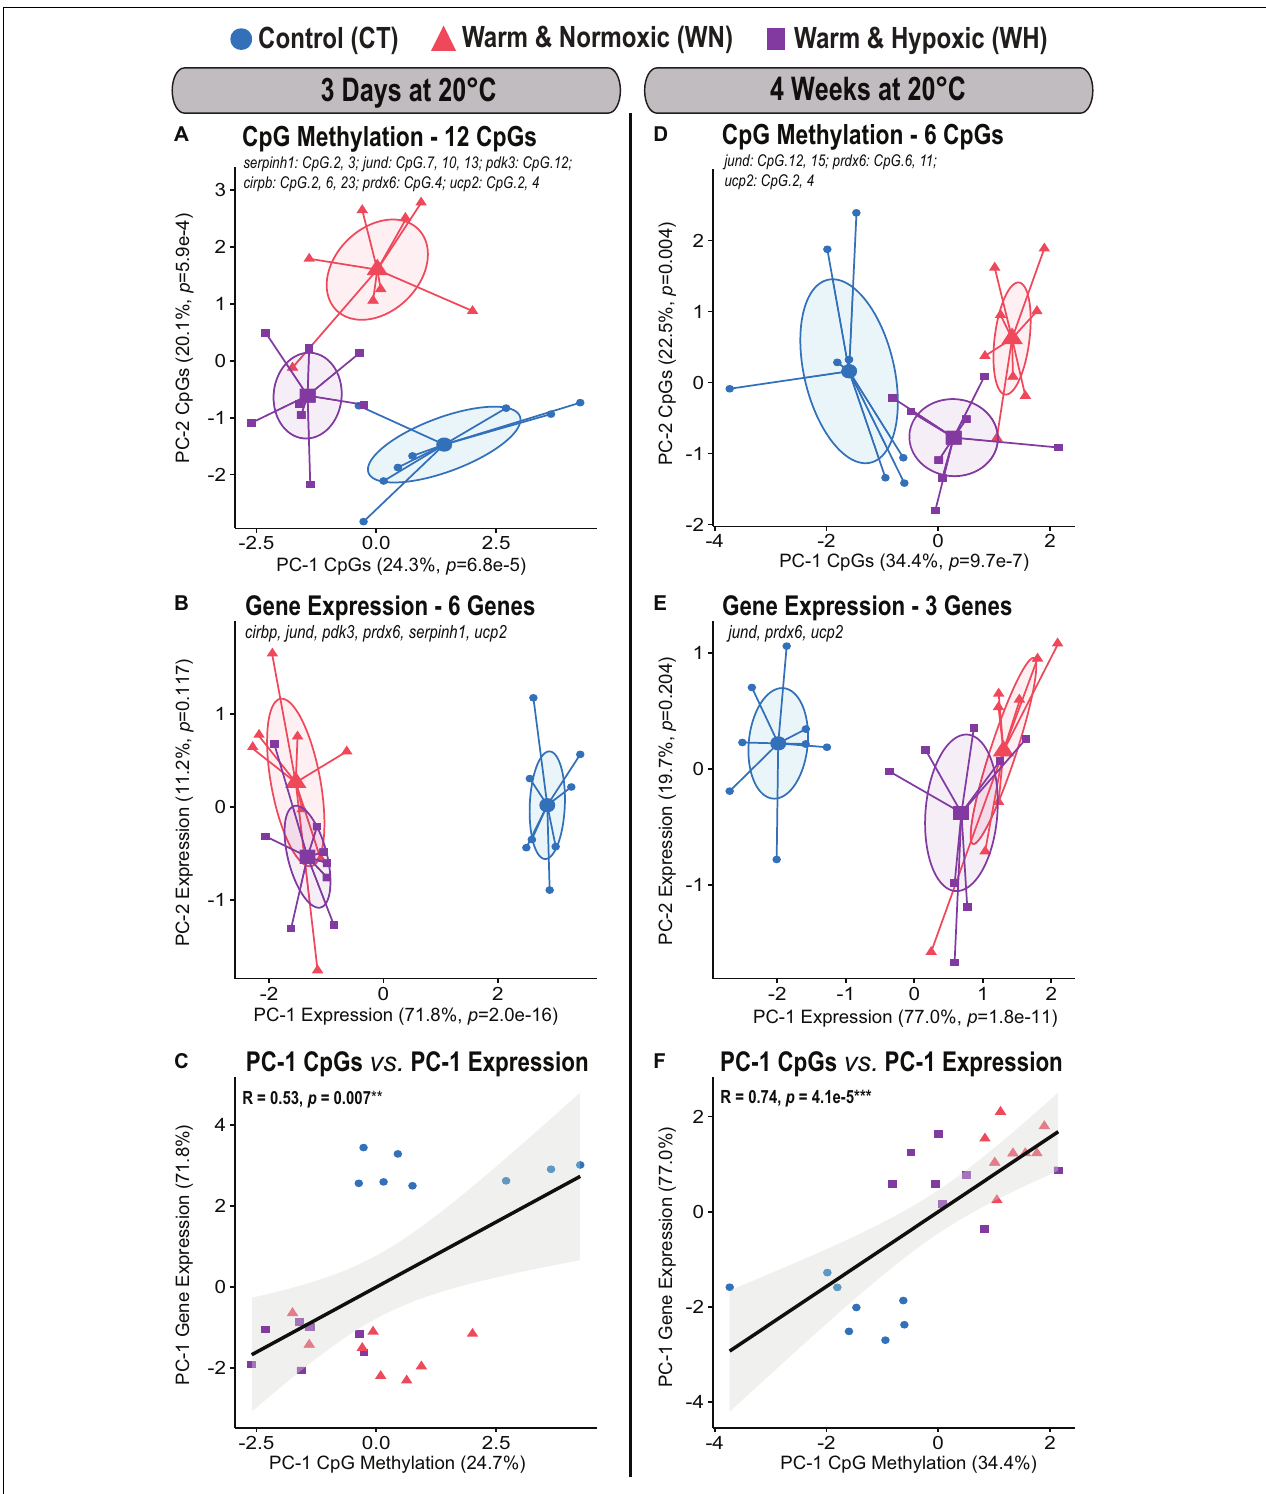
FIGURE 5 | Global DNA methylation changes in Atlantic salmon exposed to high temperature and hypoxia, and their relationship to transcript expression. Principal Component Analysis (PCA) for all significantly affected CpGs and corresponding transcript expression in the liver of Atlantic salmon exposed to high temperature alone (WN: 20 ◦ C, ∼ 100% air saturation) or combined with hypoxia (WH: 20 ◦ C, ∼ 70% air sat.) for 3 days or 4 weeks as compared to control conditions (CT: 12 ◦ C, ∼ 100% air sat.) ( n = 8 per treatment/time point, N = 48 total). (A) PCA based on 12 significantly affected CpGs after 3 days at 20 ◦ C and (B) the corresponding transcript expression PCA of six genes ( serpinh1 , jund , pdk3 cirbp , prdx6 , and ucp2 ). PCAs show cluster distribution between the CT, WN, and WH groups,